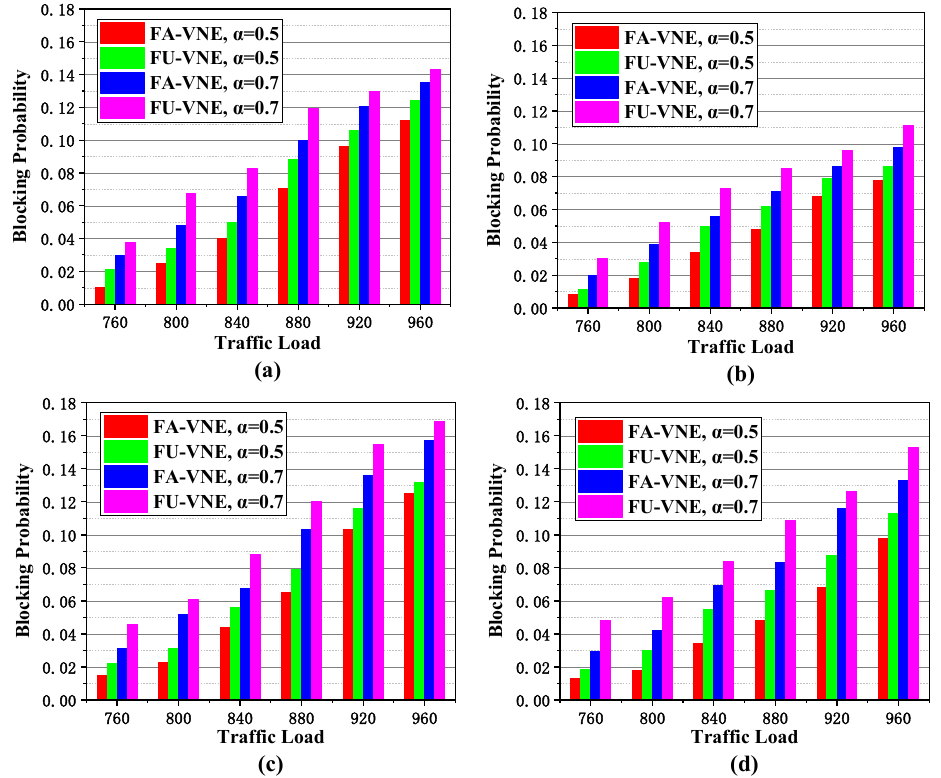
Figure 4. Simulation and results: ( a ) BP under NS-A; ( b ) BP under NS-B; ( c ) BP under NS-C; and ( d ) BP under NS-D.